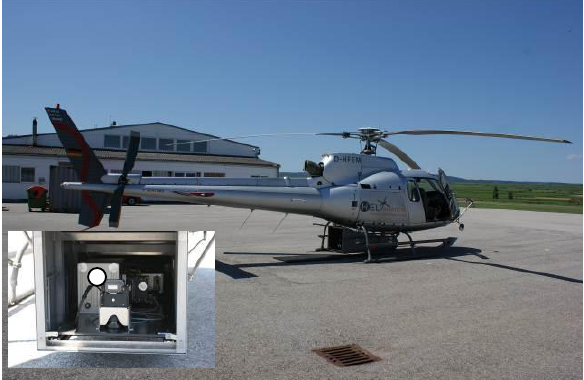
Figure 2: Helicopter carrying survey pod and integrated RIEGL system VQ820-G